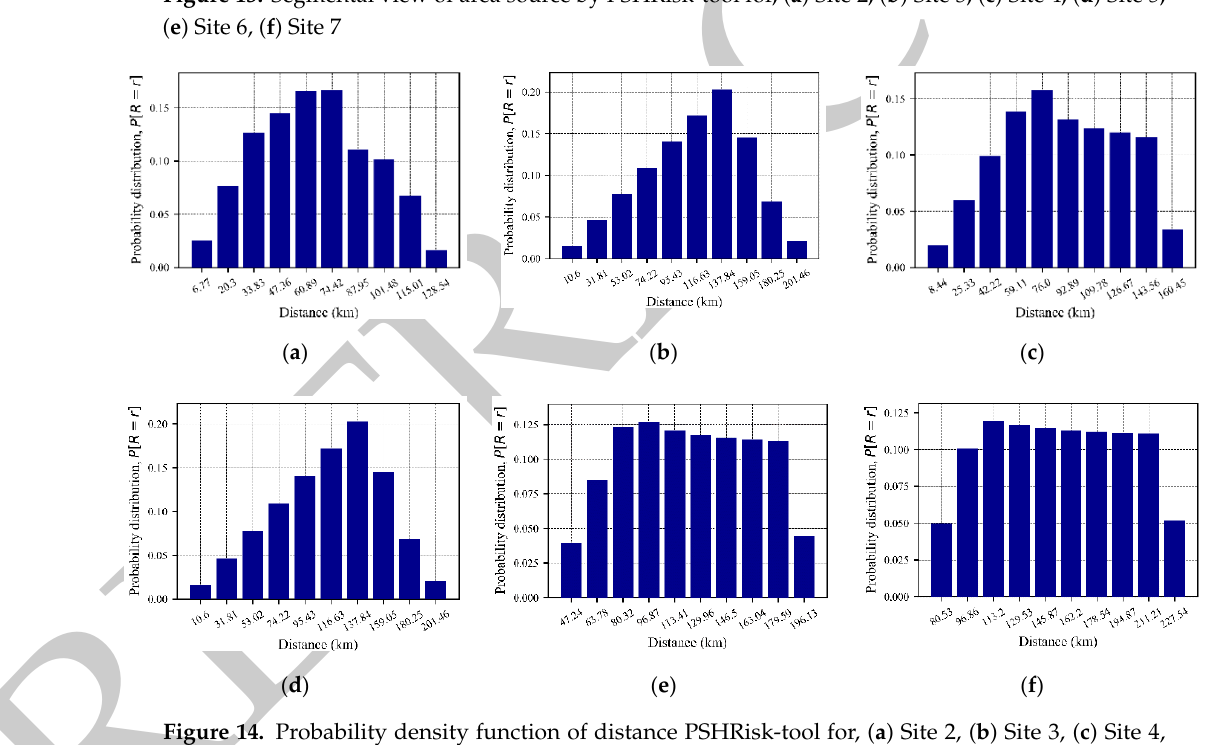
Figure 14. Probability density function of distance PSHRisk-tool for, ( a ) Site 2, ( b ) Site 3, ( c ) Site 4, ( d ) Site 5, ( e ) Site 6, ( f ) Site 7.